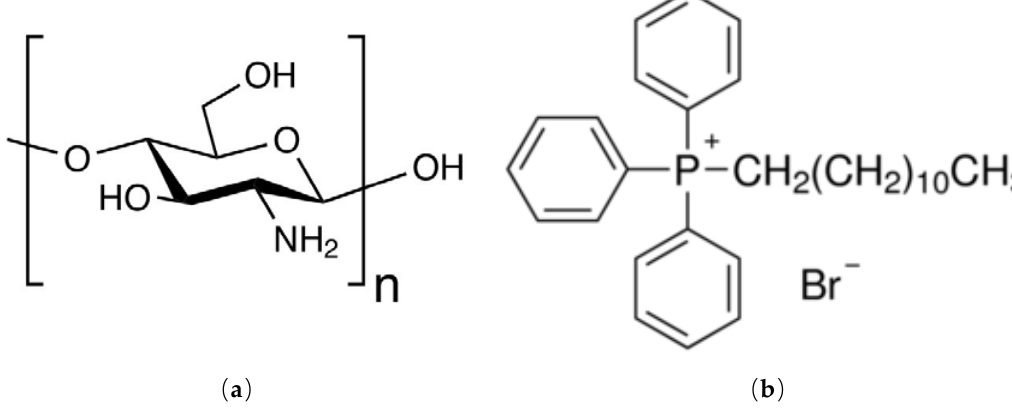
Figure 1. The structure of: ( a ) chitosan (Ch), and ( b ) dodecyl-triphenyl-phosphonium bromide (DDTPPBr).